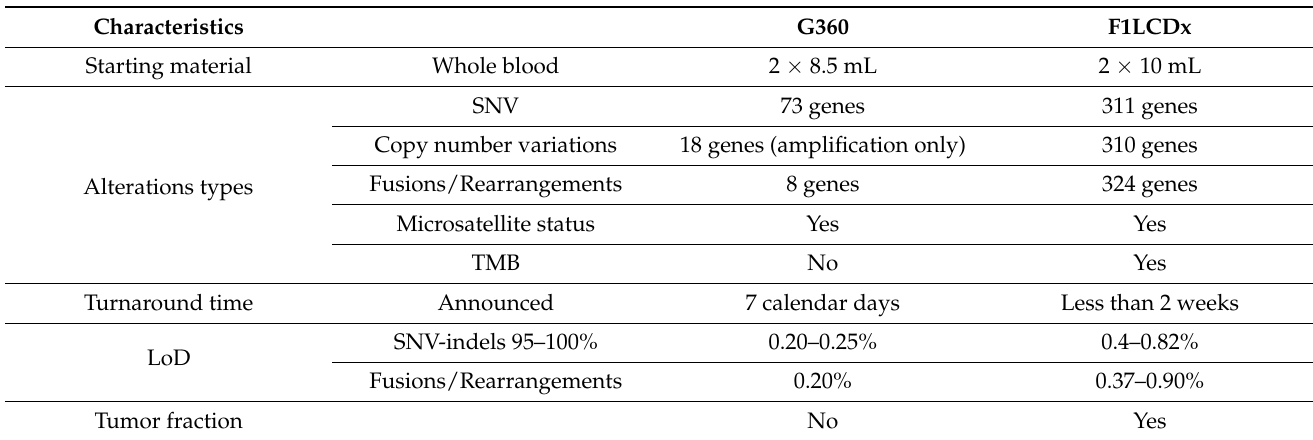
Table 1. Technological characteristics of the two FDA-approved cfDNA NGS. SNV: single-nucleotide variant, TMB: tumor mutational burden, LoD: limit of detection, G360: Guardant360 ® CDx, F1LCDx: FoundationOne ® Liquid